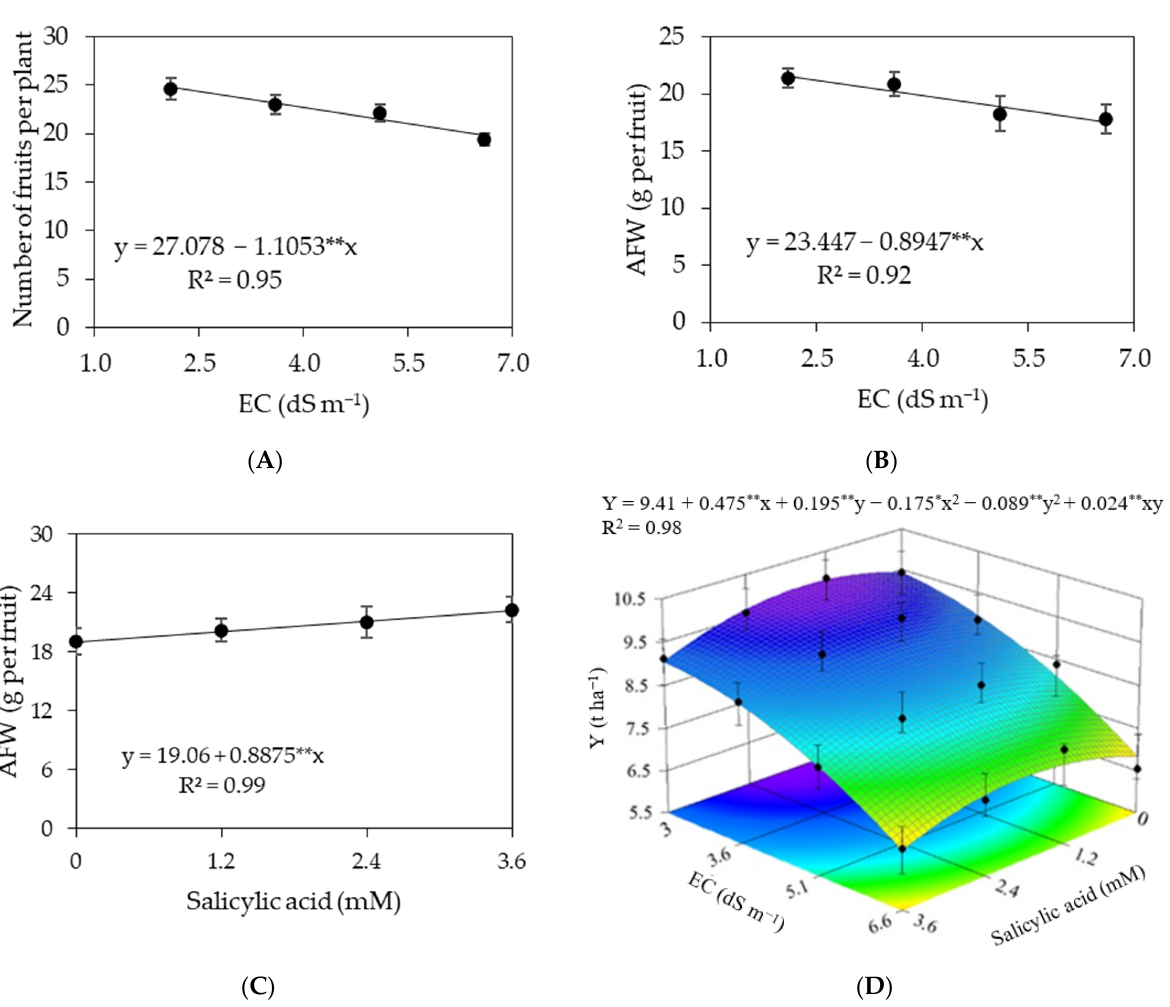
Figure 7. Number of fruits per plant—NFP ( A ), average fruit weight—AFW ( B ) of ‘Canindé’ okra as a function of the electrical conductivity of the nutrient solution—EC and the concentrations of salicylic acid ( C ), and response surface for yield—Y ( D ) of ‘Canindé’ okra cultivated in a hydroponic system as a function of the interaction between the EC and salicylic acid concentrations. X and Y—concentration of salicylic acid and EC, respectively; * and ** significant at p ≤ 0.05 and ≤ 0.01, respectively. The vertical lines represent mean +/ − standard error (n = 4).